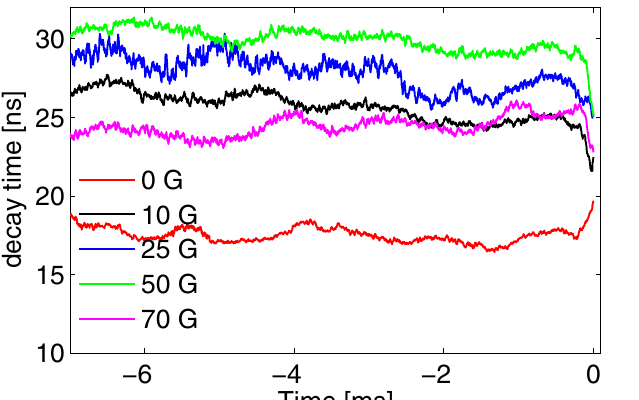
FIG. 14. (Color) The current drawn by the 40 cm long stripline electrode strongly depends on the polarity of the clearing voltage. For positive U SL the current is rather large and essen- tially constant, while it is small for negative U SL